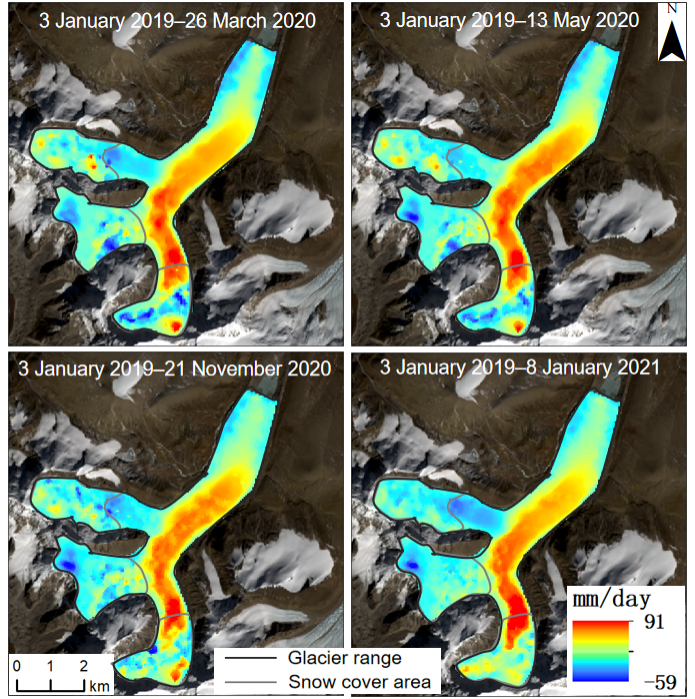
Figure 13. North–south time-series glacier velocity in the study area.